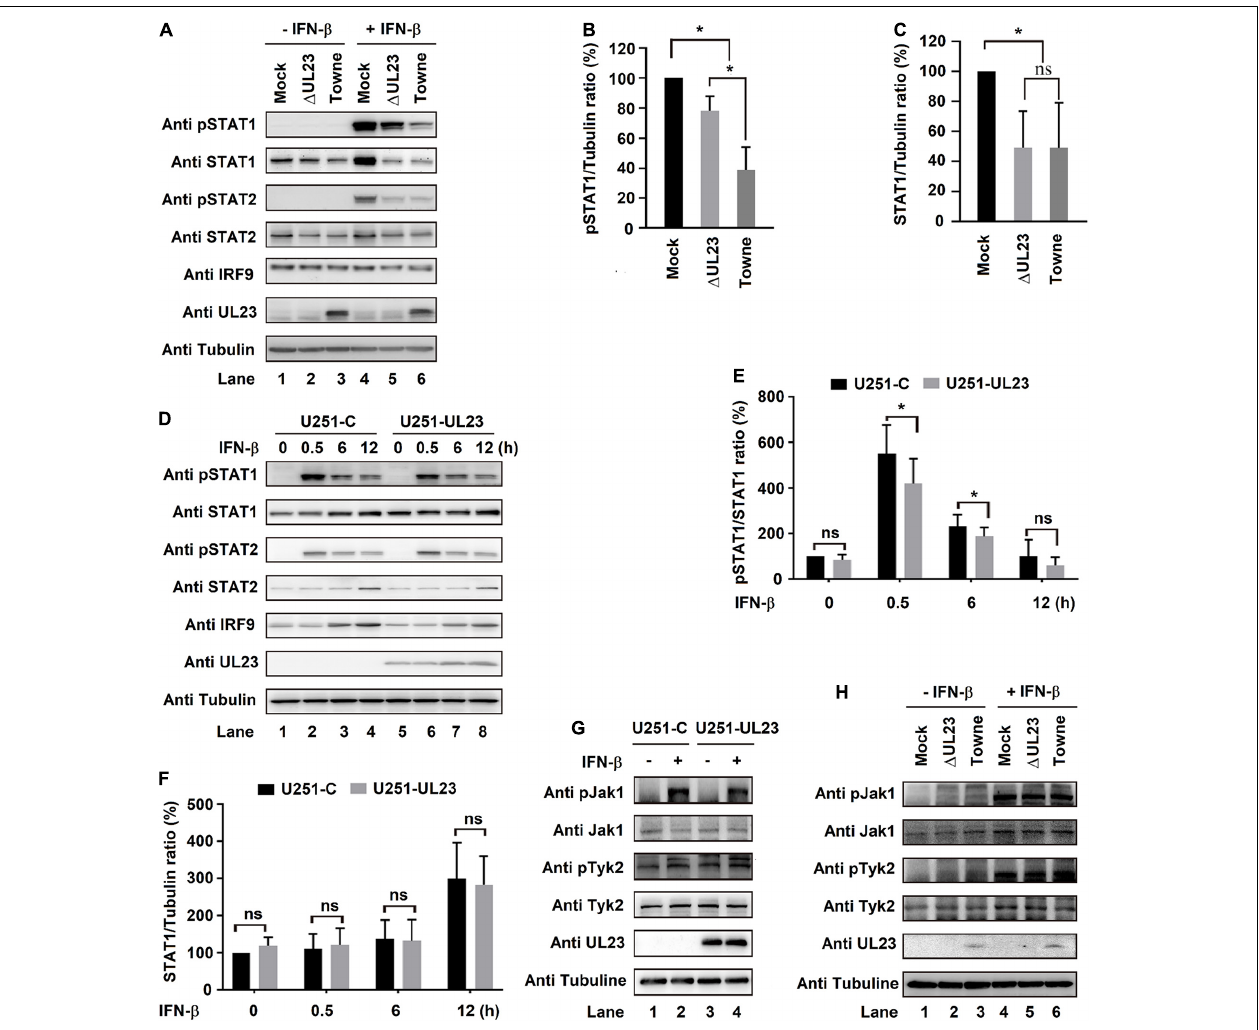
FIGURE 4 | UL23 attenuates IFN- β -mediated phosphorylation of the signal transducer and activator of transcription 1 (STAT1). (A–C) U251 cells infected with HCMV Towne or HCMV– (cid:49) UL23 (MOI = 3) for 72 h. The cells were then treated with IFN- β (100 U/ml) for 0.5 h before (A) immunoblot analysis, (B) phosphorylation detection, (C) and protein determination. (D–F) U251–UL23 cells and U251-C cells were exposed to 100 U/ml IFN- β for appropriate time periods prior to the (D) immunoblot assay, (E) phosphorylation detection, and (F) protein determination. (G) IFN- β (100 U/ml) was used to treat U251–UL23 and U251-C cells for a period of 0.5 h prior to the immunoblot assay. (H) HCMV– (cid:49) UL23 or HCMV (MOI = 3) was transfected into U251 cells for a period of 72 h, followed by 0.5 h of 100 U/ml IFN- β treatment prior to the immunoblot assay. Data are shown as mean ± SD. * p < 0 . 05, ** p < 0 . 01, *** p < 0 . 001 (unpaired, two-tailed Student’s t -test). Data are representative of three independent experiments with similar